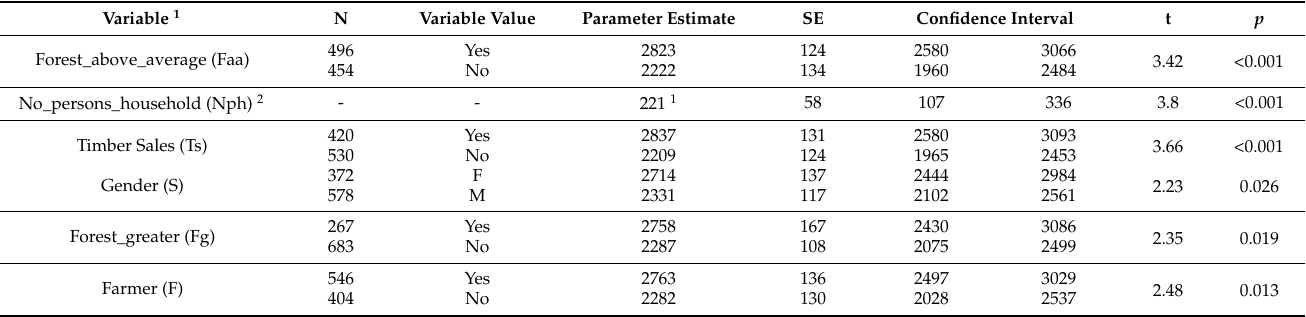
Table 6. Results of multiple regression analysis of response variable WTA3 on explanatory variables (variable values: 1, yes; 0, no; parameter estimate: expected value of WTA3) in research conducted in April 2019 on a random representative nationwide sample of forest owners (farmers). SE, standard error.